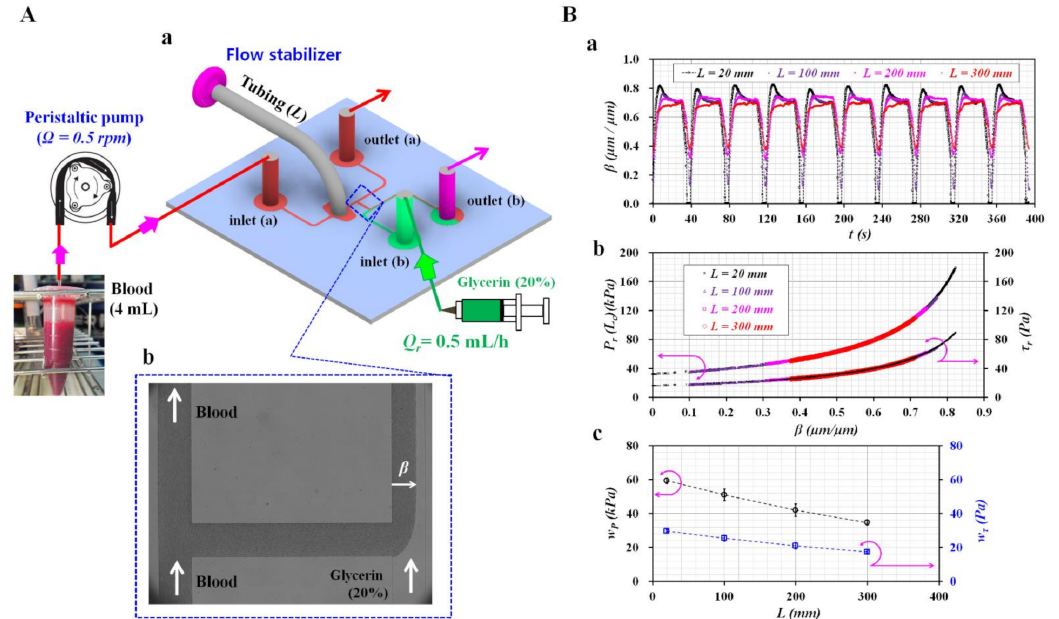
Figure 8. Contribution of flow stabilizer to four parameters (i.e., P r [ L c ], τ r , w P , and w τ ) of blood flowing under in vitro circulation. ( A ) Schematic diagram of the experimental setup for monitoring blood flow in vitro fluidic circuit. (a) The experimental setup was composed of a microfluidic device equipped with a flow stabilizer, peristaltic pump for delivering blood, and syringe pump for supplying glycerin solution (20%). The cavity of a flow stabilizer was secured by adjusting tubing length ( L = 20, 100, 200, and 300 mm), and closing one-side end with a drawing pin. A tube (~5 mL) was filled with blood (Hct = 50%, and blood volume = 4 mL). The peristaltic pump set to Ω = 0.5 rpm. The syringe pump is set to 0.5 mL/h. (b) Microscopic image of microfluidic channels filled with blood and glycerin solution (20%). ( B ) Quantifications of four parameters of blood with respect to tubing length ( L ). (a) Temporal variations of β with respect to L . (b) Variations of P r ( L c ) and τ r with respect to β and L . (c) Variations of w P and w τ with respect to L